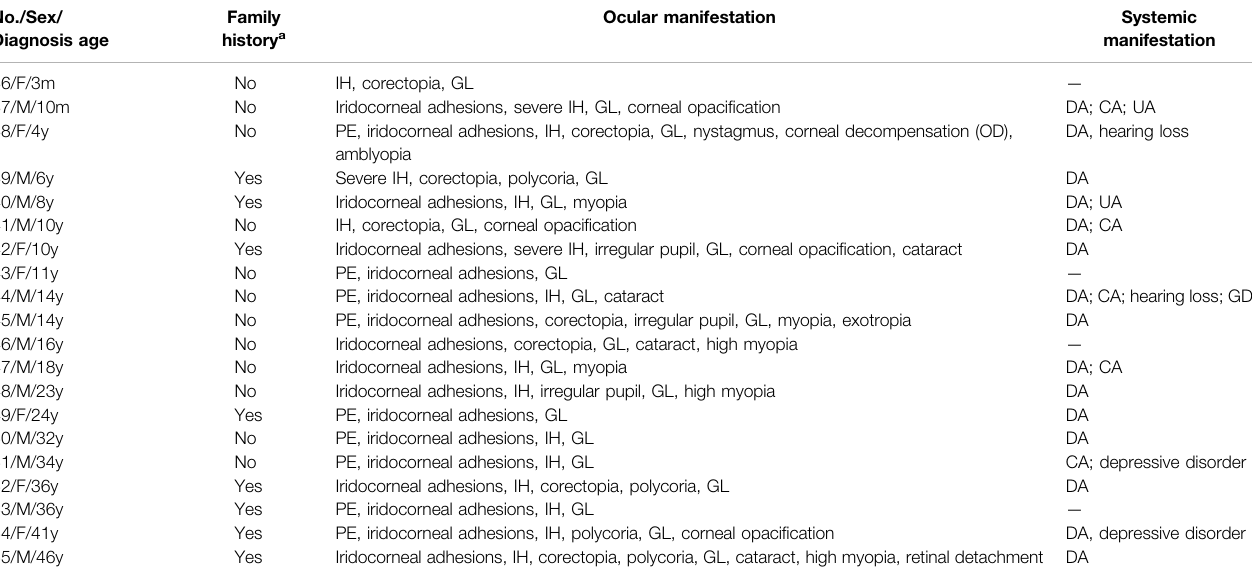
TABLE 3 | The genotype and phenotype of ARS patients without FOXC1 or PITX2